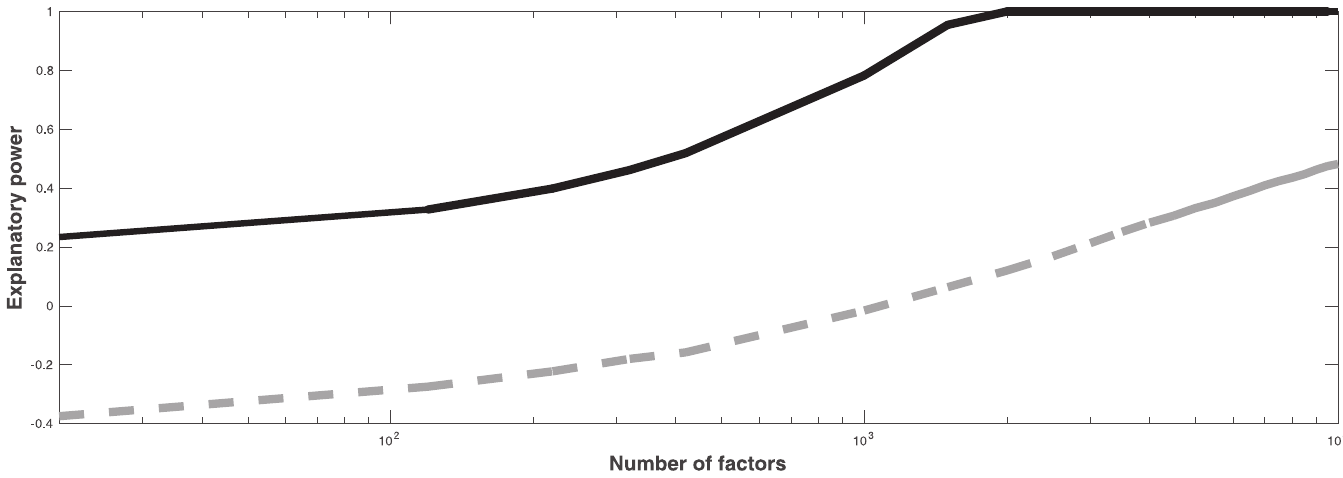
Fig 5. Explanatory power in factor modeling of data using PCA (black solid curve) and using the RFM (gray dashed curve).